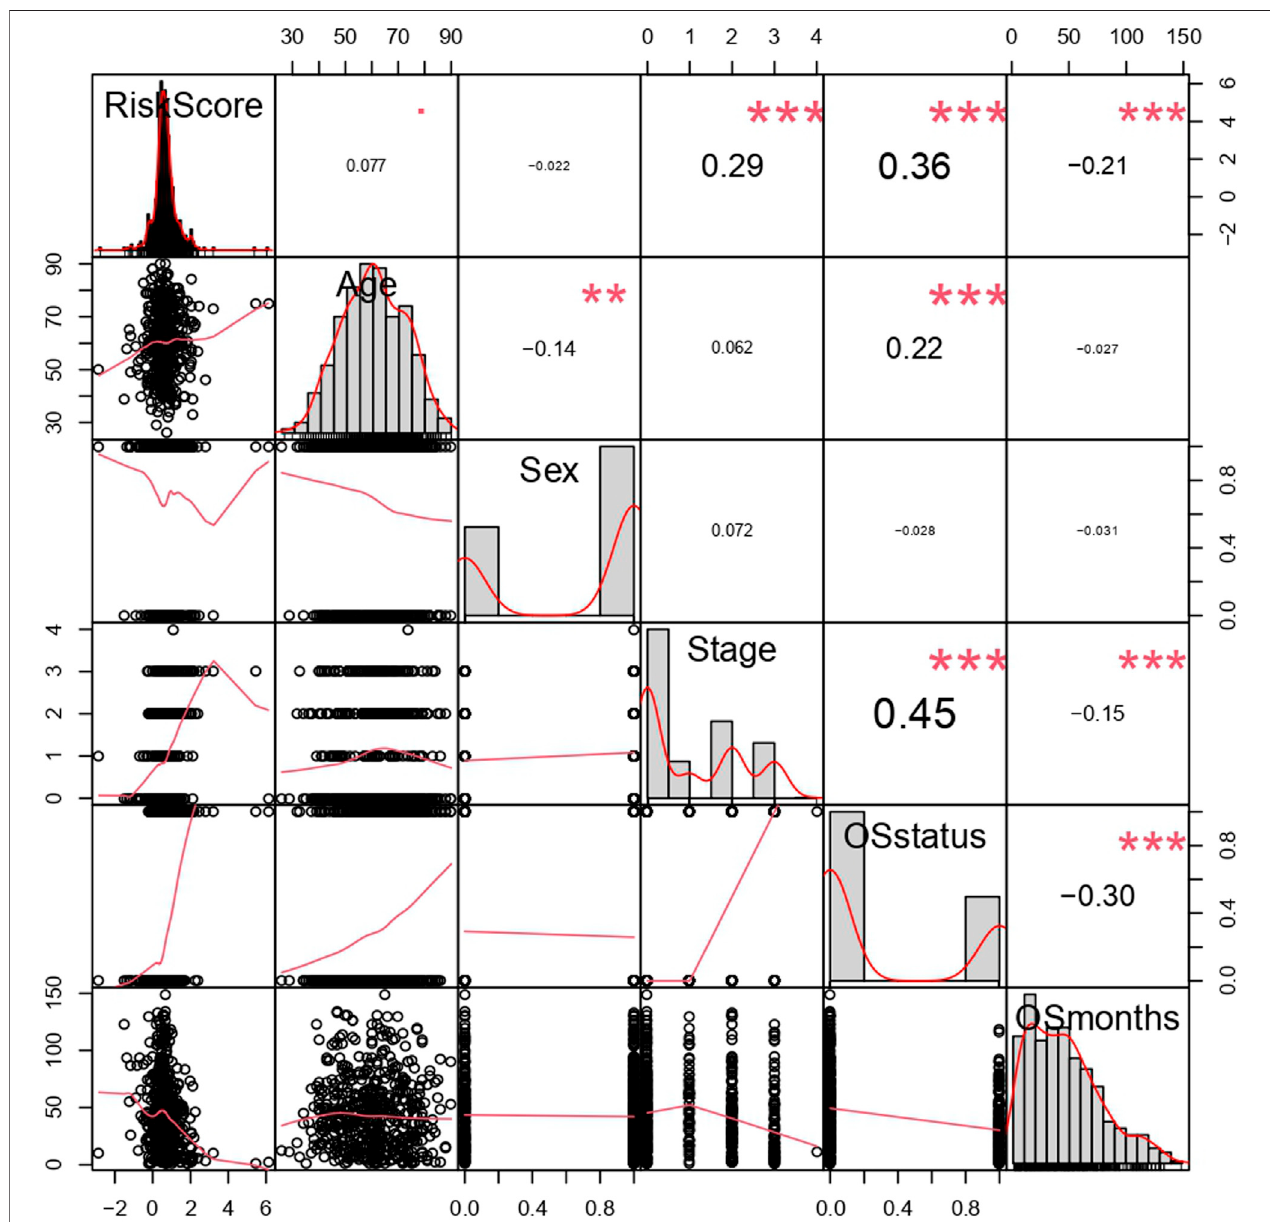
FIGURE 5 | Correlation analysis of risk score and clinical signatures. ** p < 0.01, *** p < 0.001, coef fi cients > 0 represented positive correlation while coef fi cients < 0 represented negative correlation. The bigger the |coef fi cient| is, the more relevant the terms were.